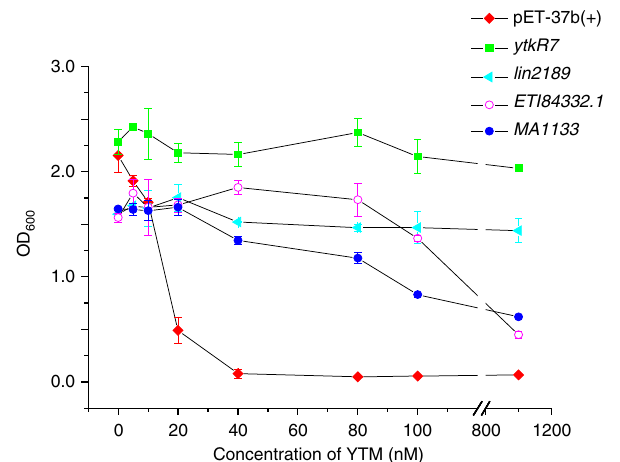
Fig. 4 CCHs can protect E . coli against the potent DNA-alkylating agent YTM. Four selected CCH proteins include YtkR7, lin2189, ETI84332.1, and MA1133, which cover from both bacteria and archaea (from diverse environments, including soil and the human